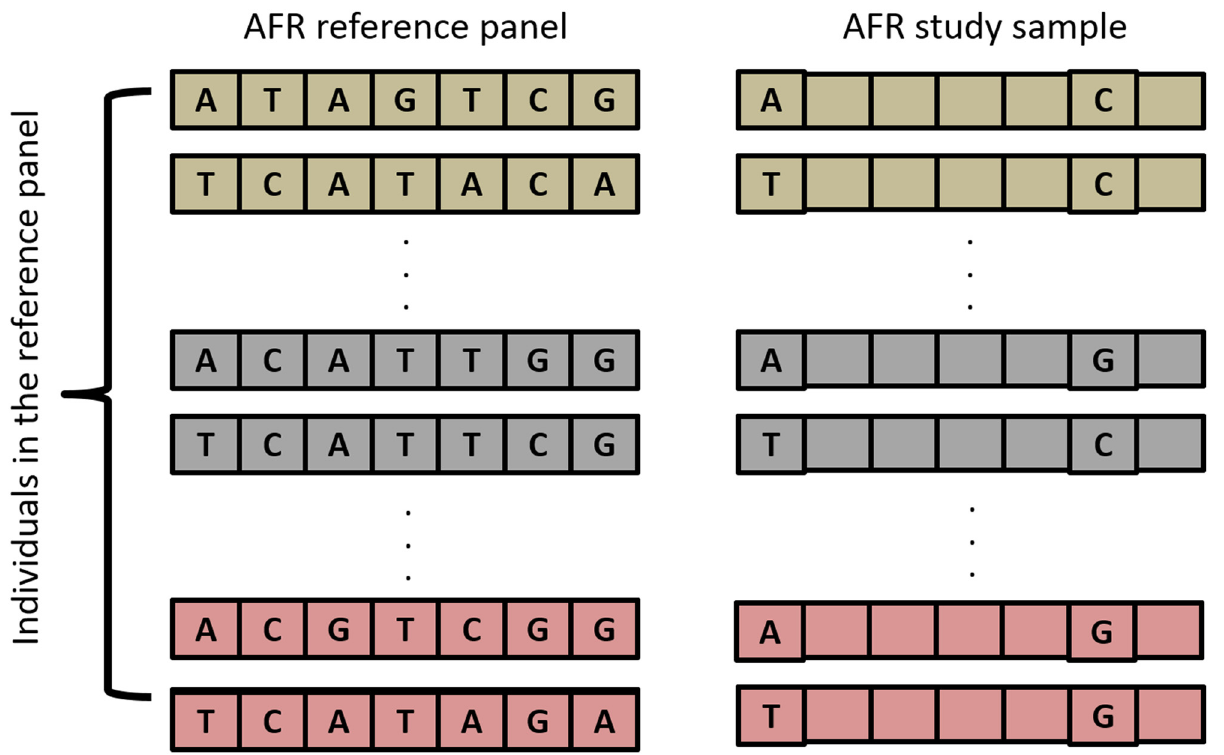
Fig 1. General process for creating the study sample for imputation. The reference panel was masked to mimic a commercial SNP array, resulting in a study sample which contains the same individuals as the reference panel.